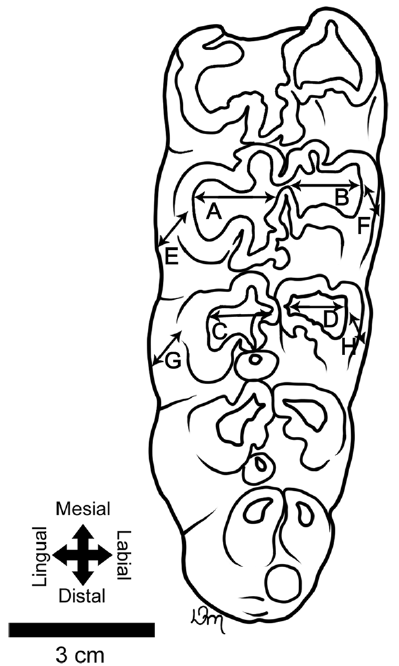
Fig. 2 – Diagram of a left M 3 tooth of Stegomastodon waringi with the measured regions (Oclusal view). A) Greater width of lingual met- alophid cusp depression. B) Greater width of labial metalophid cusp depression. C) Greater width of lingual tritolophid cusp depression. D) Greater width of labial tritolophid cusp depression. E) Greater height of lingual metalophid cusp. F) Greater height of labial met- alophid cusp. G) Greater height of lingual tritolophid cusp. H) Greater height of labial tritolophid